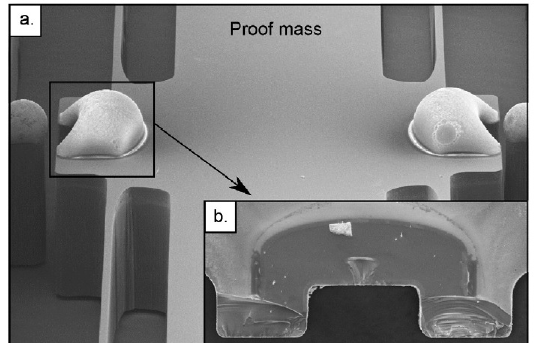
Figure 17. ( a ) Bumpers created through the reflow of solder on metal pads (before shocktesting); ( b ) solder bumper failed at the pad–wafer interface during a shock